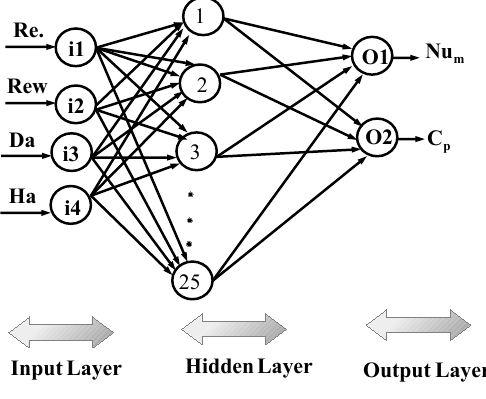
Figure 15. A schematic view of the NN structure with inputs, outputs and layers.